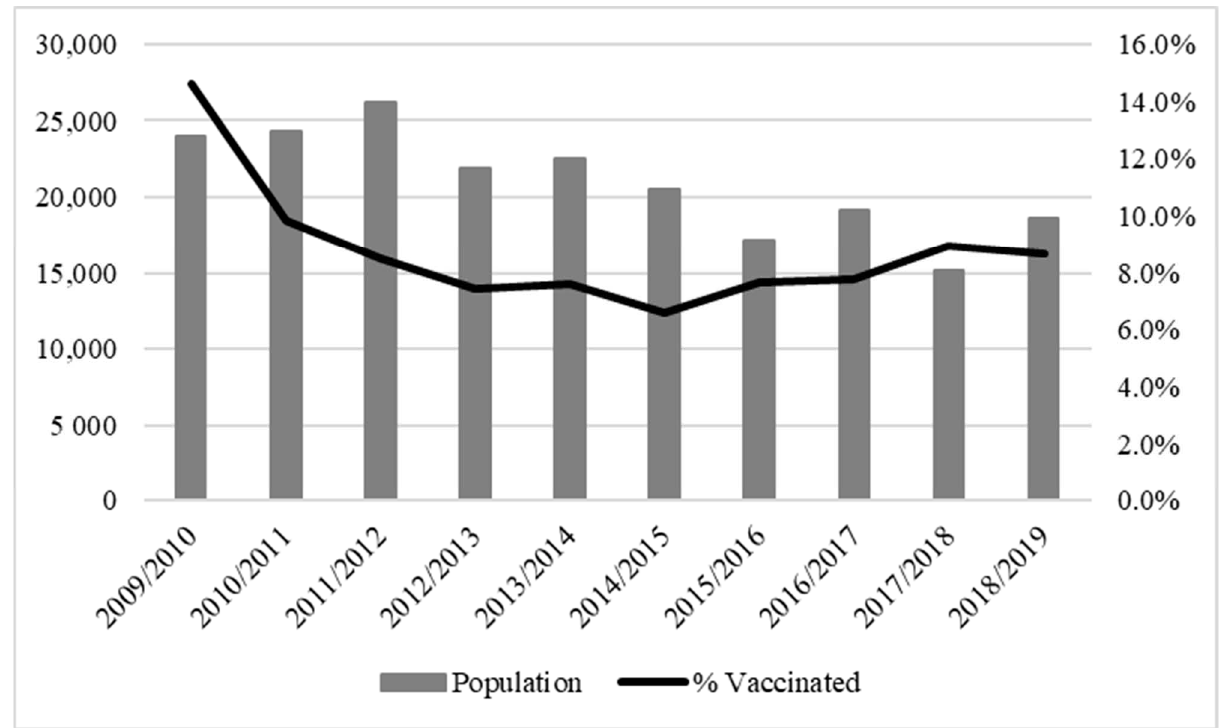
Figure 3. The trend of influenza vaccination among influenza seasons of interest from 1 October 2009 to 30 April 2019. Pedianet, 2009–2019. to 30 April 2019. Pedianet,